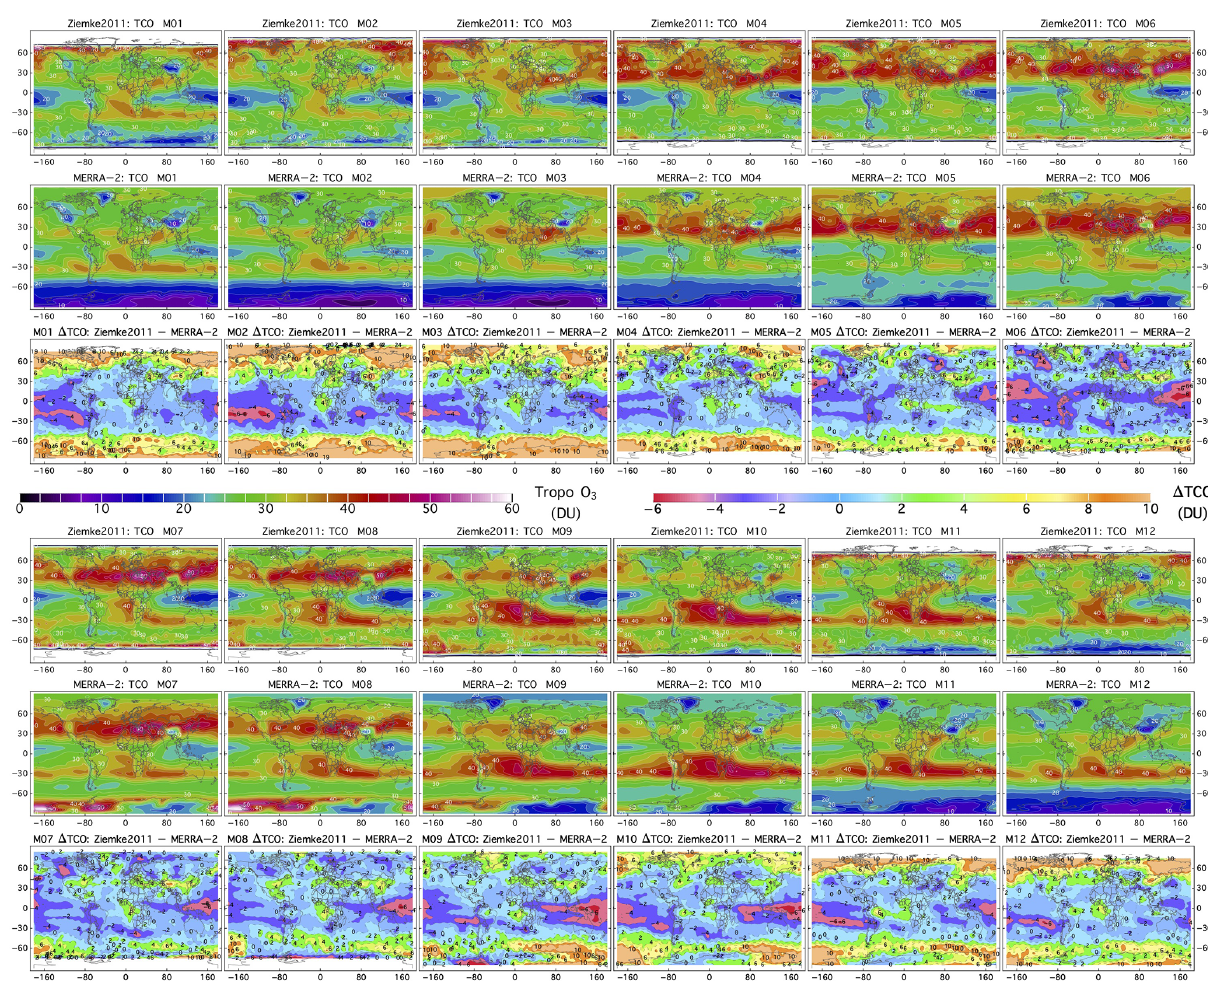
Figure 12. Similar to Fig. 11, except for tropospheric column O 3 (TCO).